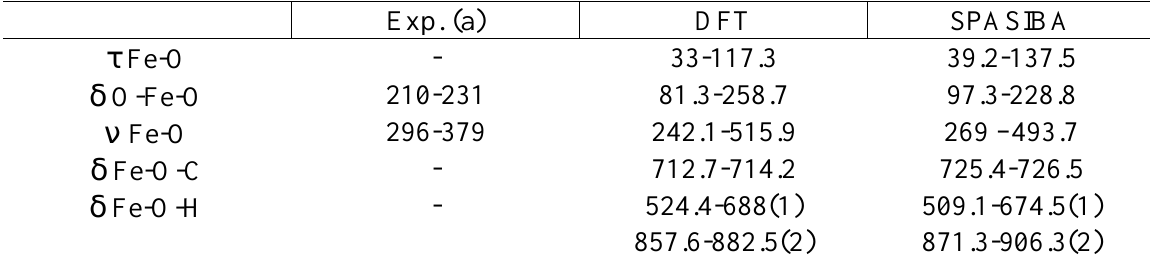
Table 7 . Calculated and observed vibrational wavenumbers (in cm -1 ) of the two ferrous